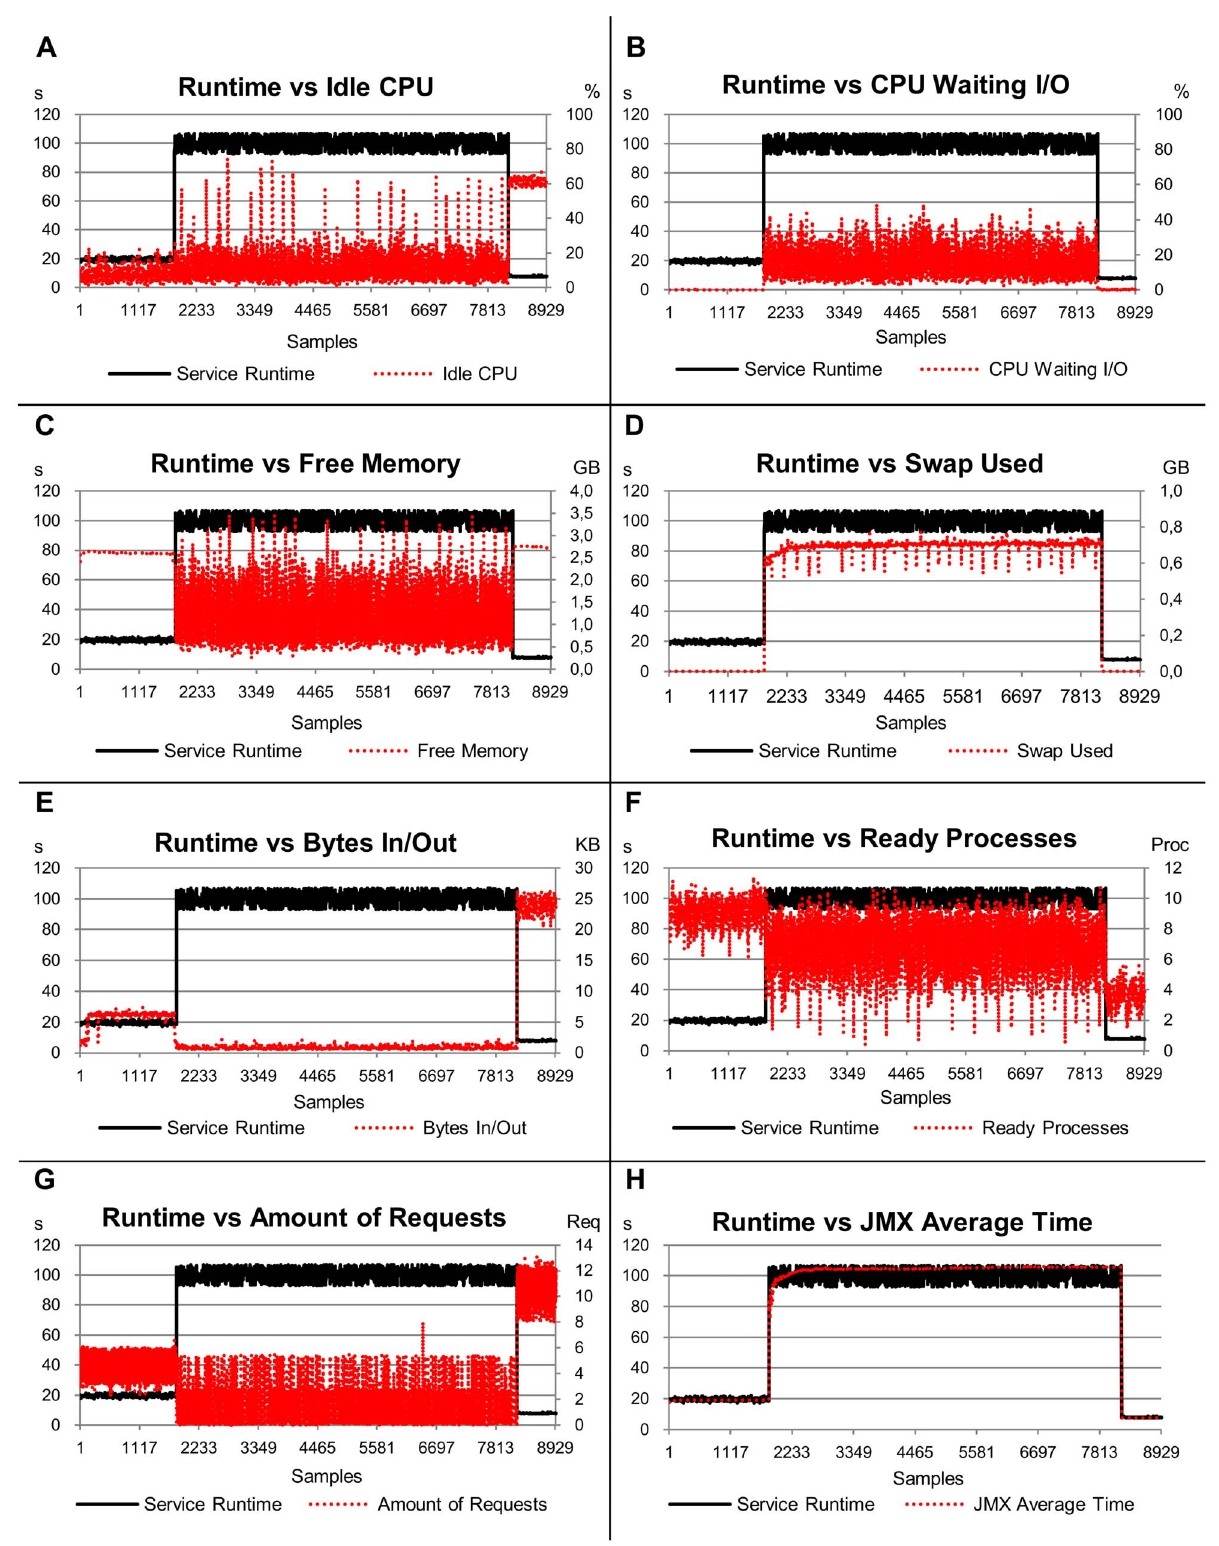
Figure 7. Relation of the service runtime versus eight load indices, considering the fifth scenario (overloaded platform). The left- hand scale of the y-axis always represents the service runtimes in seconds (s). The right-hand scale of the y-axis, where necessary, represents the metric used by the load index. The x-axis represents the samples collected every 10 s by Ganglia and JMX while the benchmarks were requesting services for the server.